Question: Author a descriptive caption for the visualization shown.
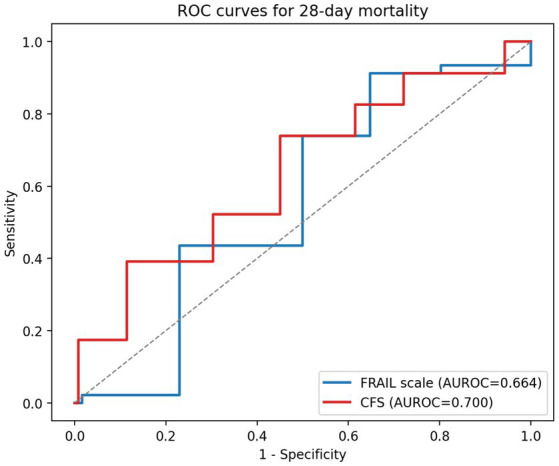
Answer: Receiver operating characteristic curves for FRAIL and CFS total scores predicting 28-day mortality.